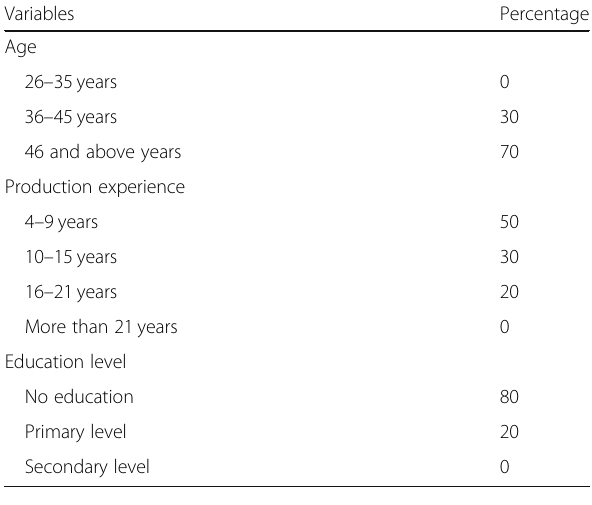
Table 1 Socio-demographic characteristics of koche processors